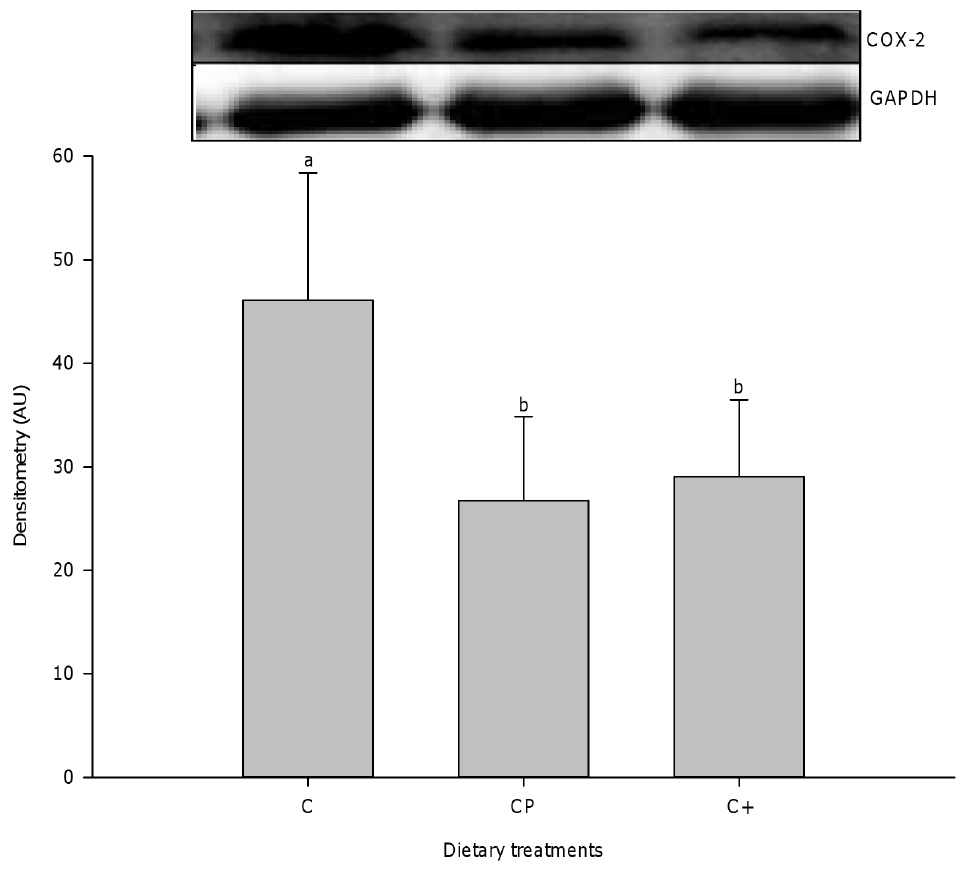
Figure 5. Expression level of COX-2 performed by immunoblotting. The protein level of COX-2, as a good marker of inflammation, was quantified in the tibialis anterior muscle of rats at 2 days post-bupivacaine injection. All values were corrected for GAPDH as a protein loading control (mean ± SEM, n = 3/group). Groups bearing different letters for a given time point are significantly different (p≤0.05). C, casein; CP, cod protein; C + , casein supplemented with L-arginine, glycine, L-taurine and L-lysine. doi: